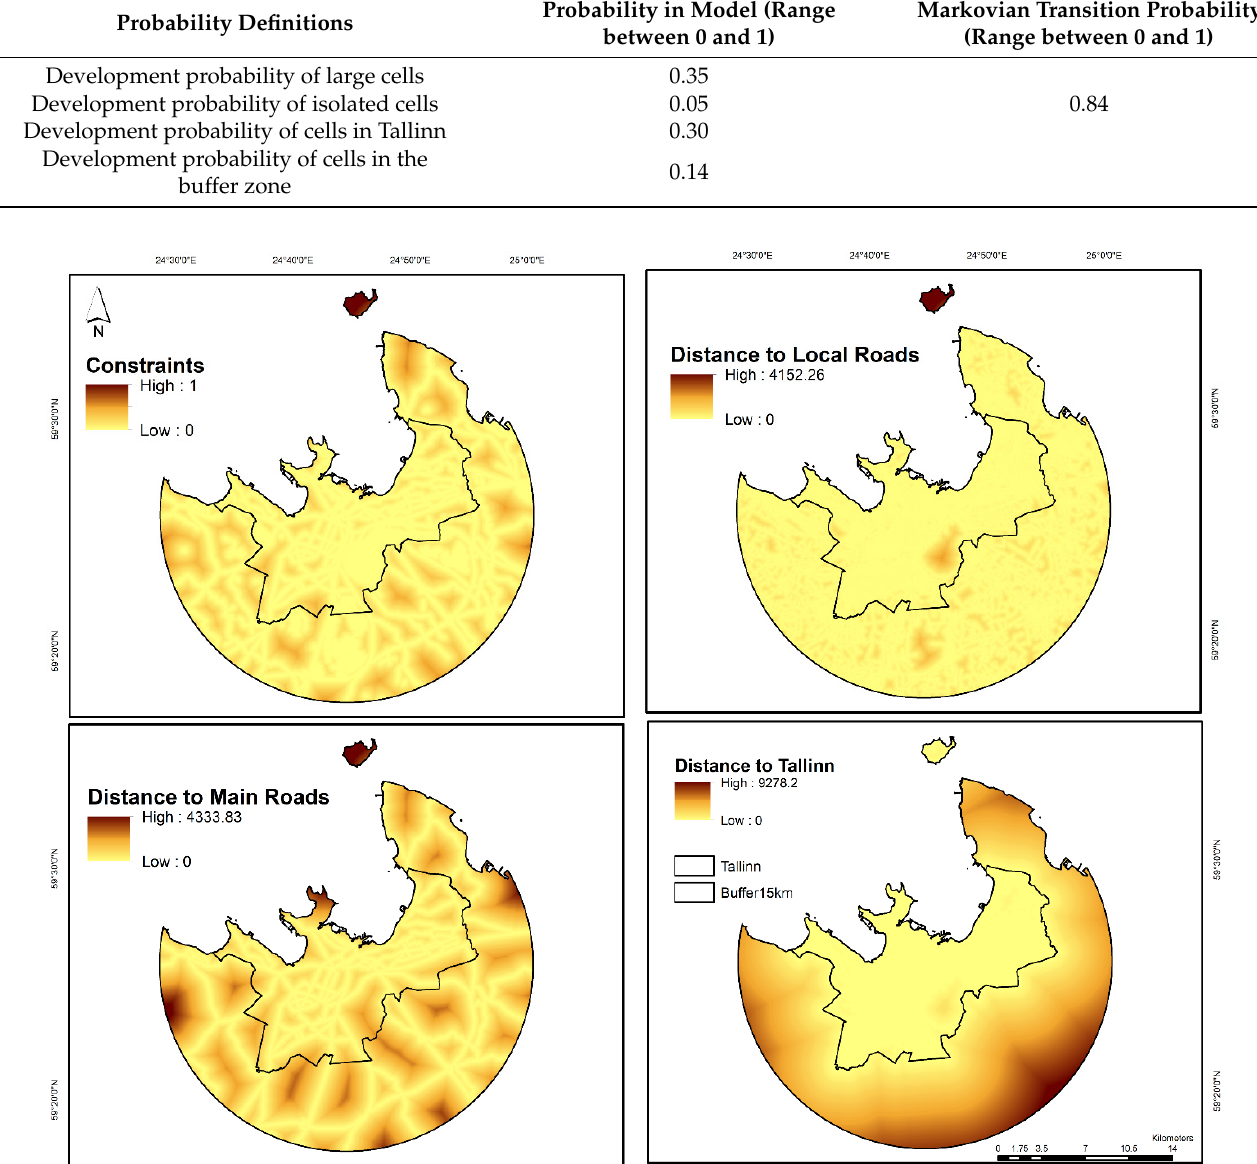
Table 5. Markovian transition probability used in the model.